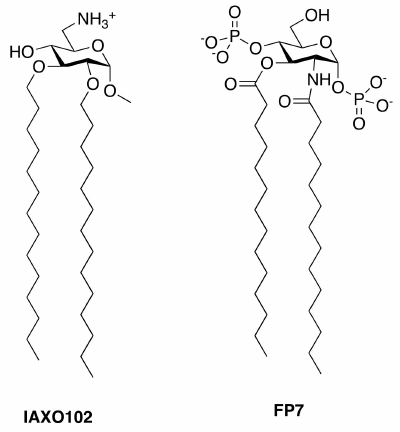
Figure 6. Positively and negatively charged monosaccharides active as TLR4